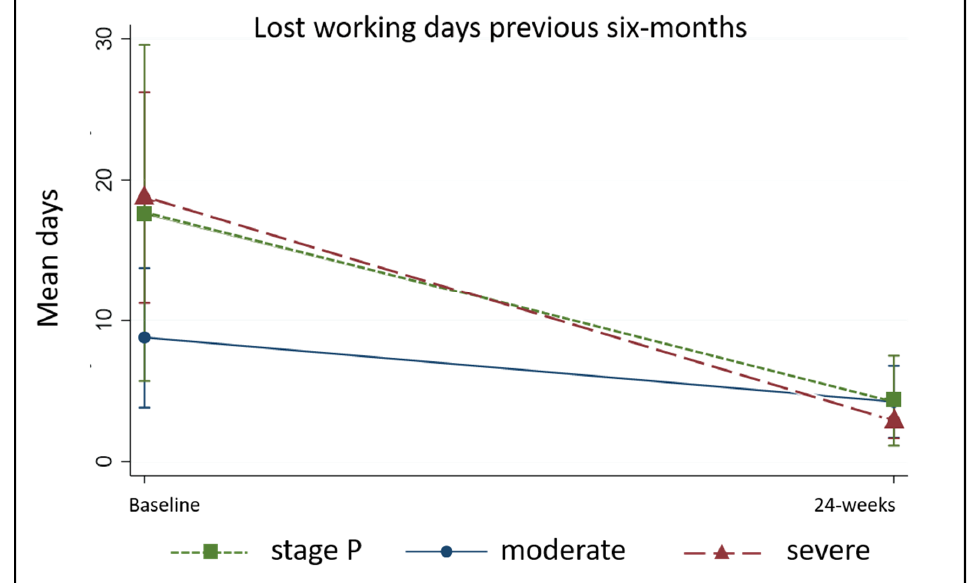
Figure 11. Number of lost working days by stage.